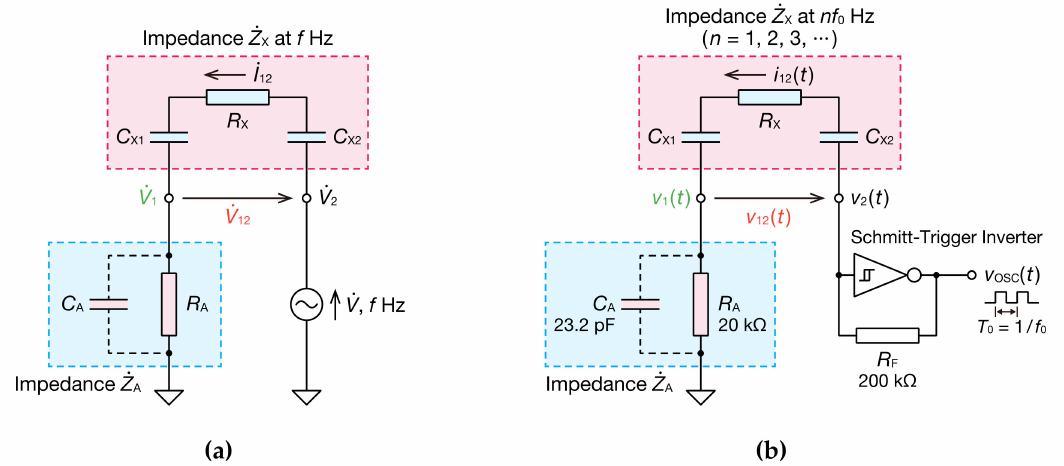
Figure 2. Circuit diagrams illustrating the measurement of impedance shown in Figure 1: ( a ) with a sinusoidal voltage source; and ( b ) in a non-sinusoidal